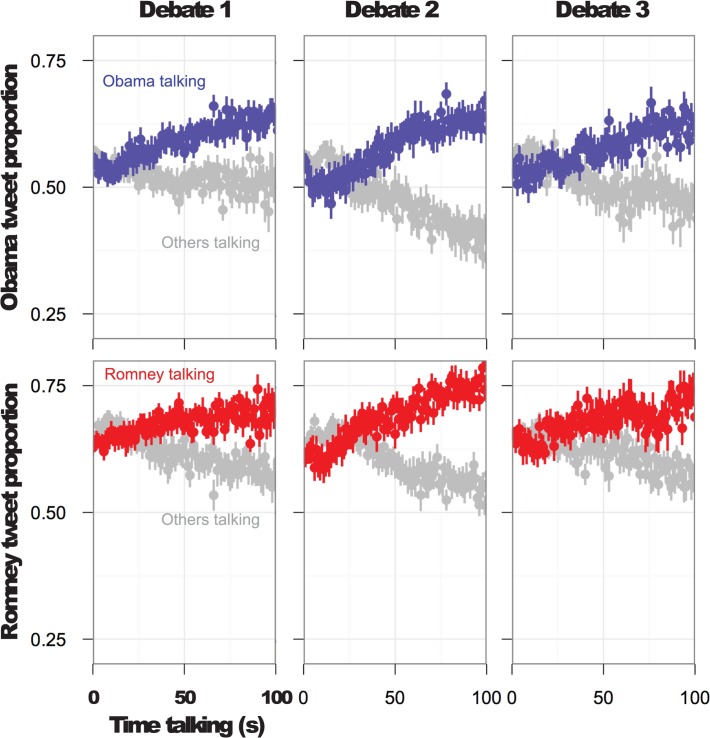
Effects of taking and holding the ground on Twitter mentions.Starting from the onset of each turn per candidate, plots show relative proportion of Twitter mention rises during that candidate's turn. While others are speaking, proportion mentions drops. Proportions are based on, for example, dividing mention to "Obama" divided by the sum of mentions to "Obama" and "Romney" together. Importantly, these plots only include original tweets, showing the anticipated effect is independent of retweets.